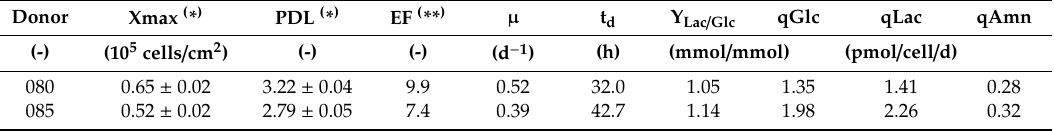
Table 3. Overview of the main growth-dependent parameters in the 2D cultivations.